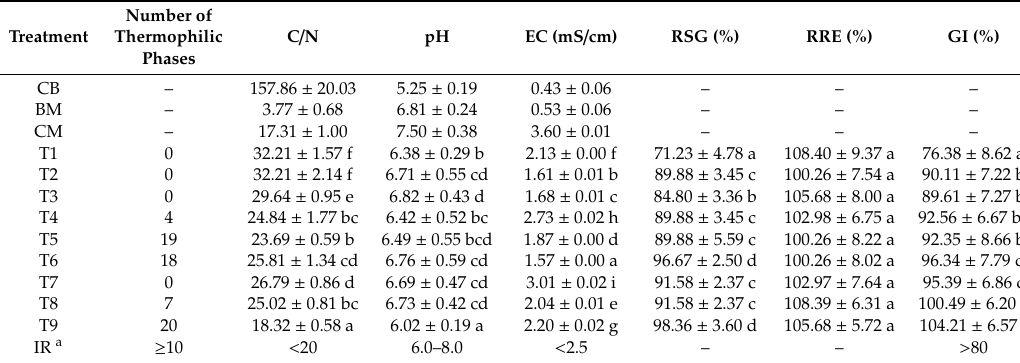
Table 4. Criteria used to evaluate the maturity of the final compost products or mixtures. Treatments T1–T9 are detailed in Table